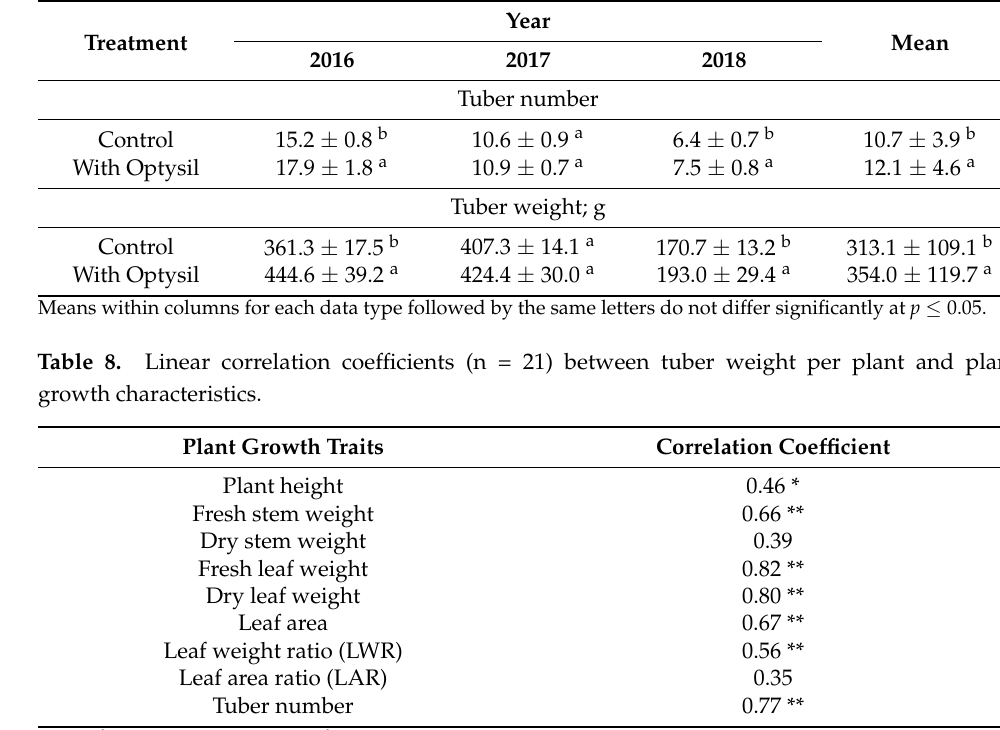
Table 7. Effect of Optysil on tuber number and tuber weight.